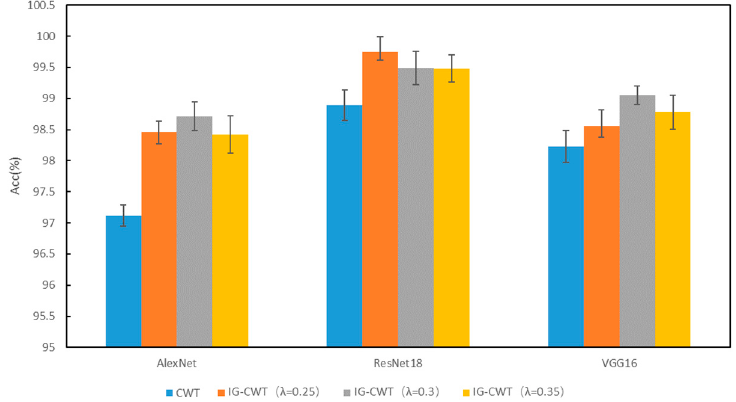
Figure 7. JNU accuracy of IG-CWT and CWT.